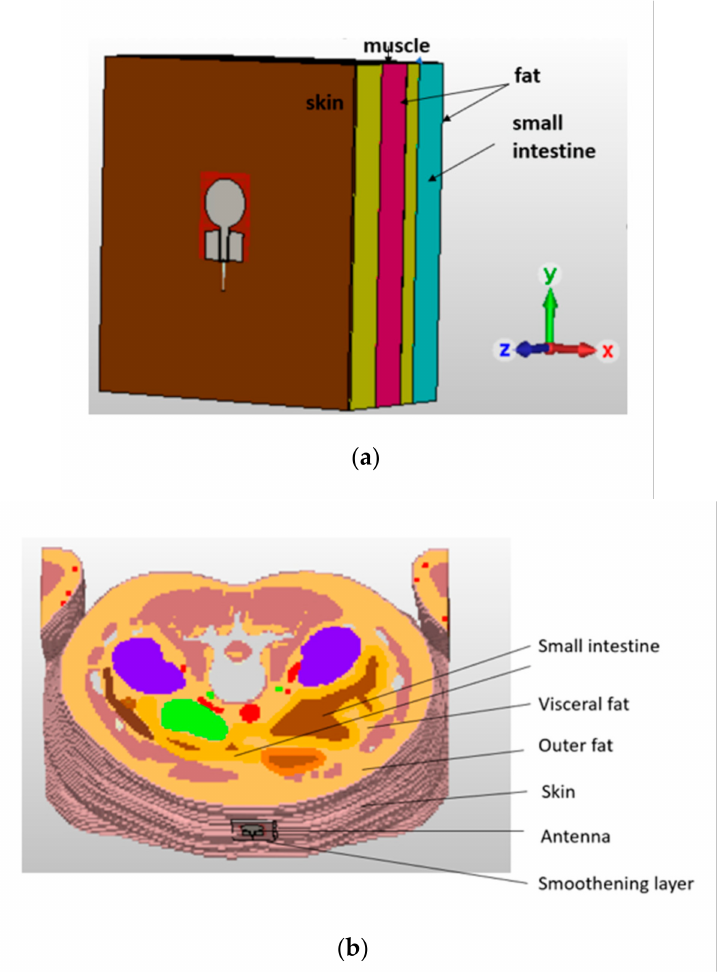
Table 2. Thicknesses of the tissue layers, relative permittivity ( (cid:101) r ) of tissue and wavelength in the tissue ( λ ) at different frequencies. Tissue